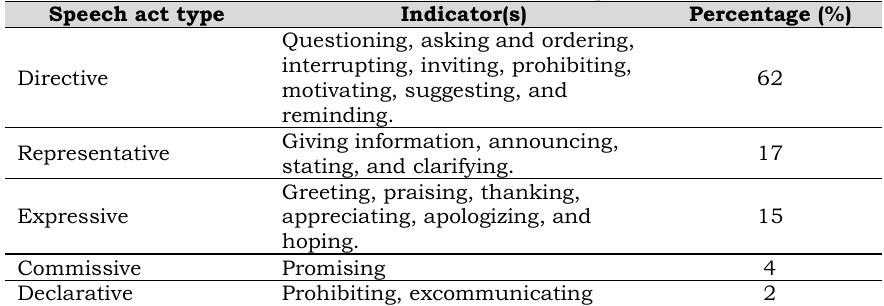
Table 1. The research